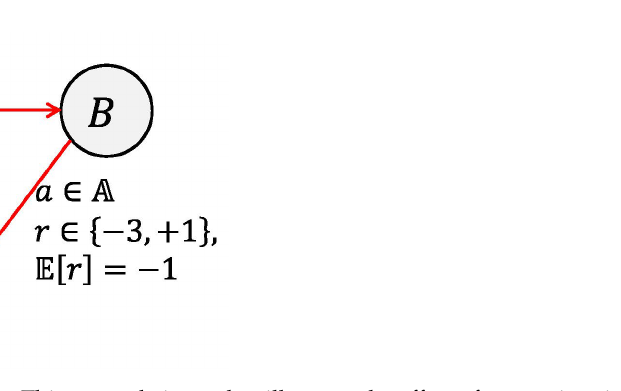
Figure 6. Overestimation Bias. This example is used to illustrate the effect of overestimation bias (see text for complete explanation).